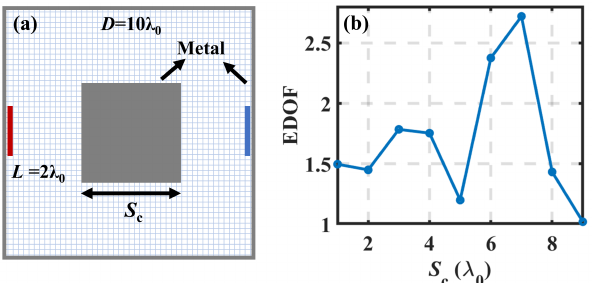
Figure 7. EDOF limit in a metallic cavity structure: ( a ) Diagram of the cavity. The lengths of the source and receiving lines are both L = 2 λ 0 , and the distance between them is D = 10 λ 0 , and the side length of the cavity is slightly larger than D . A metallic square obstacle, with the side length S c , is placed in the center between the source and receiving lines; ( b ) EDOF limit versus S c .